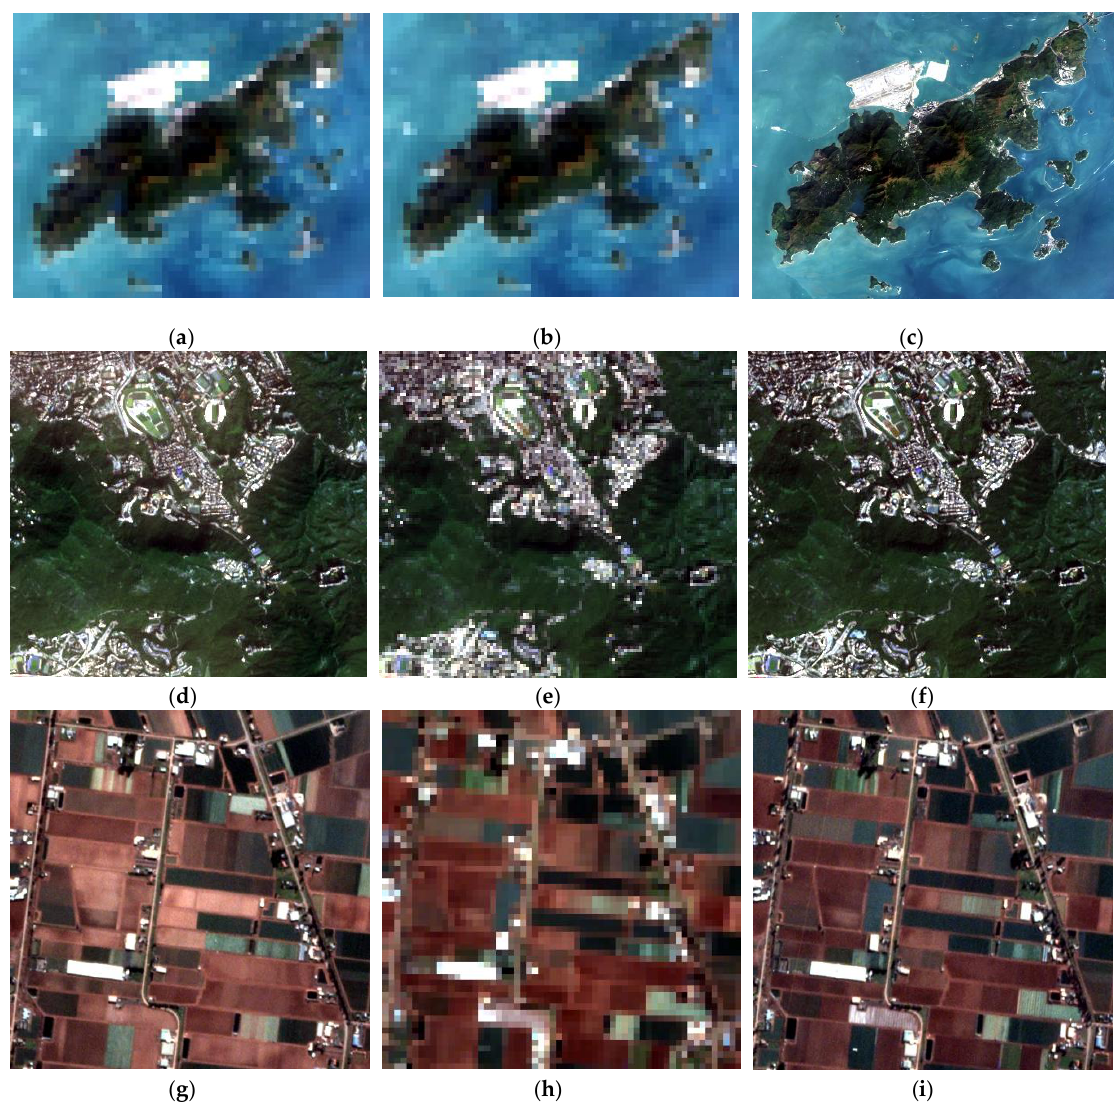
Figure 5. Simulated datasets: ( a ): Landsat 8 on 12/31/2013 (30 m) for study area 1; ( b ): Resampled Landsat 8 on 10/18/2015 (480 m) for study area 1; ( c ): Landsat 8 on 10/18/2015 (30 m) for study area 1; ( d ): Sentinel-2 on 1/1/2016 (10 m) for study area 2; ( e ): Resampled Sentinel-2 on 2/14/2017 (30 m) for study area 2; ( f ): Sentinel-2 on 2/14/2017 (10 m) for study area 2; ( g ): PlanetScope on 6/22/2018 (3 m) for study area 3; ( h ): Resampled PlanetScope on 5/31/2018 (30 m) for study area 3; ( i ): PlanetScope on 5/31/2018 (3 m) for study area 3.